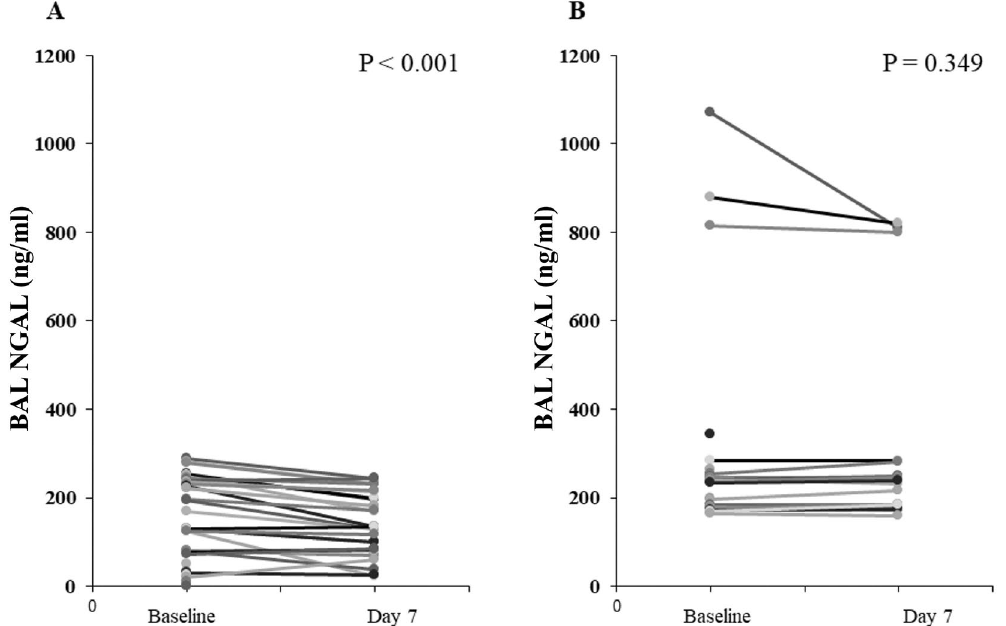
Figure 3. NGAL level of baseline and day 7 in bronchoalveolar lavage. A paired t-test was used to compare baseline BAL NGAL and day 7 BAL NGAL [( A ) survivors ( B ) non-survivors]. BAL bronchoalveolar lavage, NGAL Neutrophil gelatinase-associated